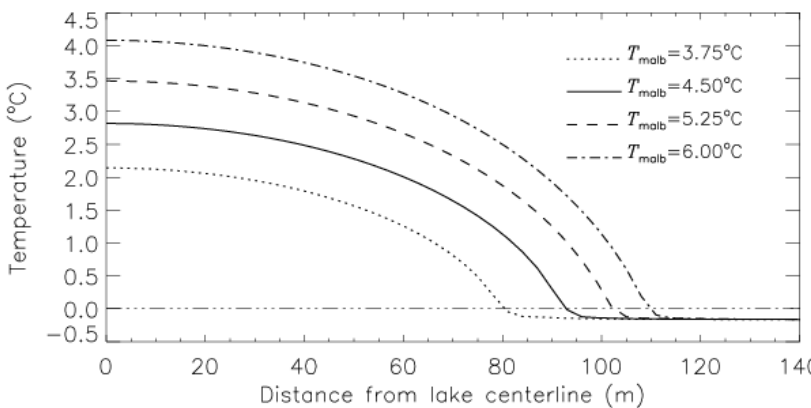
Figure 8. The horizontal profiles of ground temperature along depth x = 40 m beneath the thermokarst lakes with different long-term mean lake bottom temperatures at year 600 after each thermokarst lake formation.